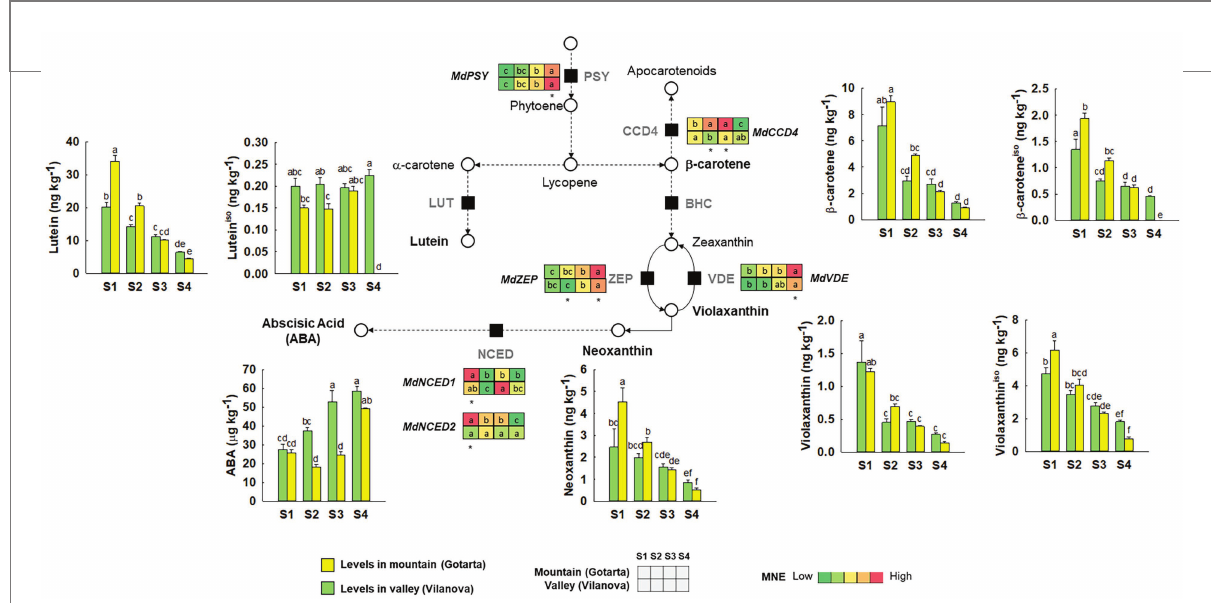
FIGURE 3 Comparison of carotenoid metabolism in “Golden Reinders” apples grown in mountain (Gotarta- ) or valley (Vilanova- ) orchards during fruit development/ripening. Dashed lines indicate that some steps have been omitted. Quantified carotenoid compounds are represented in bar plots, including minor carotenoid isomers marked with the superscript “iso.” Error bars represent the standard error ( n = 4). Letters, whenever available, indicate significant differences for the interaction location*developmental stage according to Tukey test ( p ≤ 0.05). The corresponding transcript levels of the main genes are represented as heatmaps. Letters within the heatmaps indicate significant differences ( p ≤ 0.05) between development stages, while asterisk denote differences among locations at each specific development